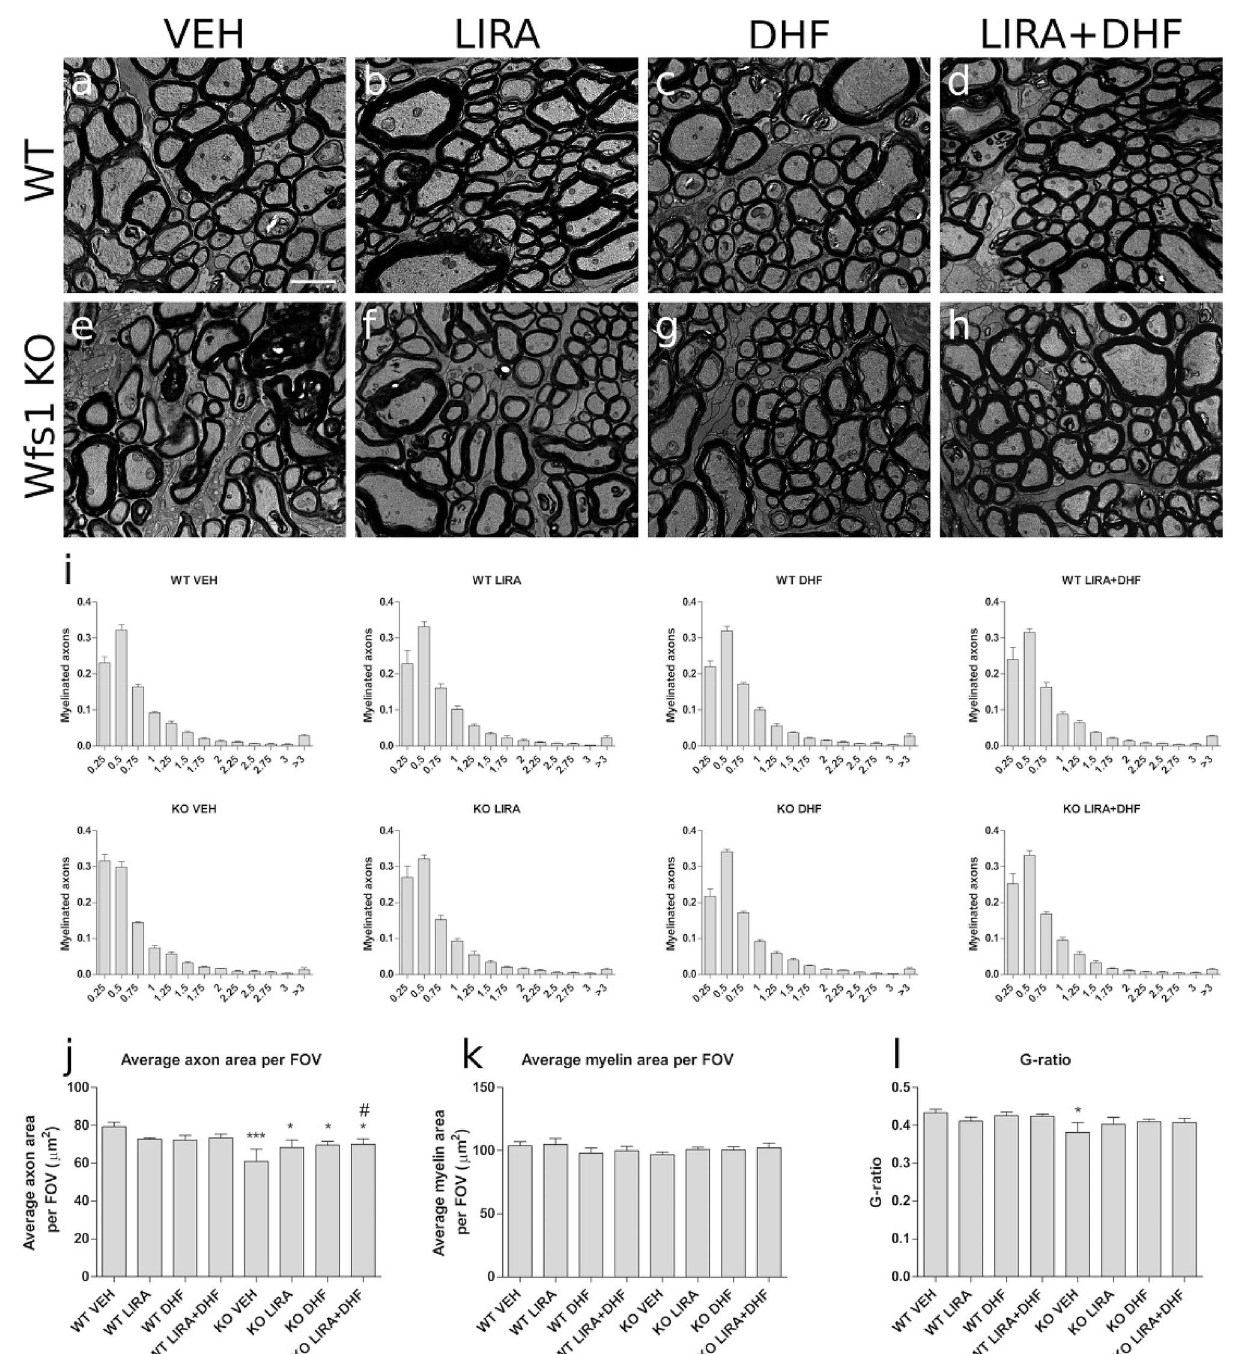
Figure 3. 3.5-month treatment with liraglutide, 7,8-DHF or with their combination delayed the progression of optic nerve atrophy in Wfs1 KO animals. Electron micrographs representing cross-sections from analyzed ( a – d ) WT and ( e – h ) Wfs1 KO rat’s optic nerves from corresponding treatments, liraglutide (LIRA), 7,8-DHF (DHF) or liraglutide and 7,8-DHF (LIRA + DHF). ( i ) Optic nerve axon size distribution in every treatment group, ( j ) average axon area per field of view (FOV), ( k ) average myelin area per FOV, ( l ) G-ratios calculated as total axonal area divided by total axonal area plus myelin area. Quantitative data were compared using factorial ANOVA followed by Fisher’s LSD tests; *p < 0.05; ***p < 0.001 compared to WT vehicle animals and # p < 0.05 compared to KO Sal animals. The data are presented as the mean ± SEM, n = 4–7 per group. Scale bar: 2